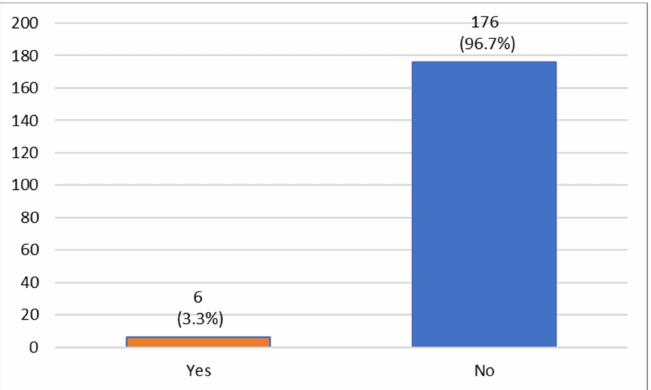
Figure 2. Distribution of the answers given by children regarding vegetarian diet.